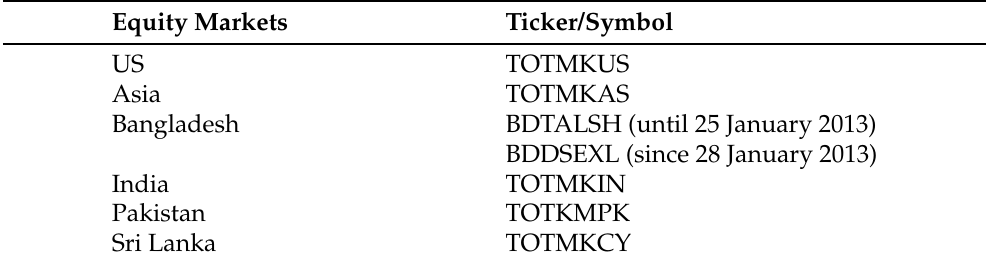
Table 2. Ticker of equity indices in